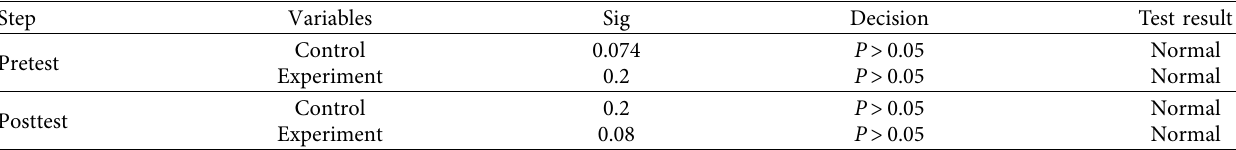
Table 2: Test table for normality of variables in the pretest the upper-intermediate groups for